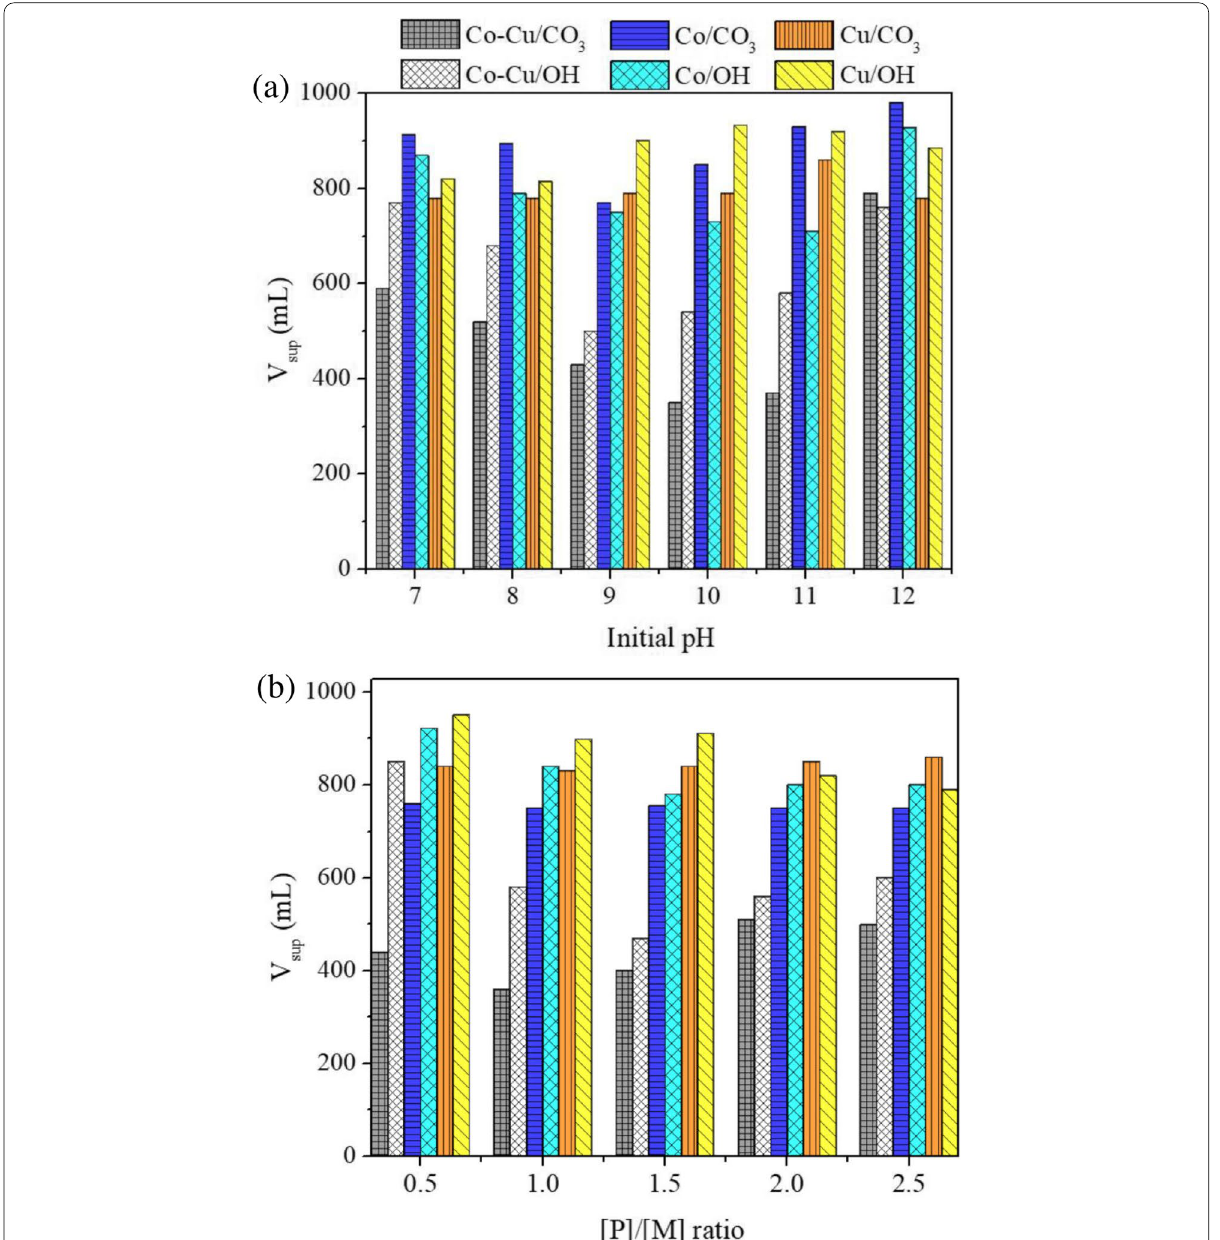
Fig. 13 Supernatant volume after 30 min under different heavy metals systems at different ( a ) pH values and (b) precipitant‑to‑metal ratio via carbonate and hydroxide